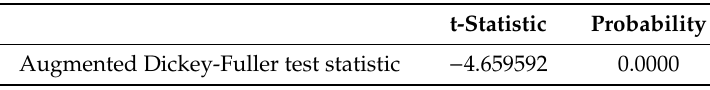
Table 7. Engel–Granger two-step (cointegration)